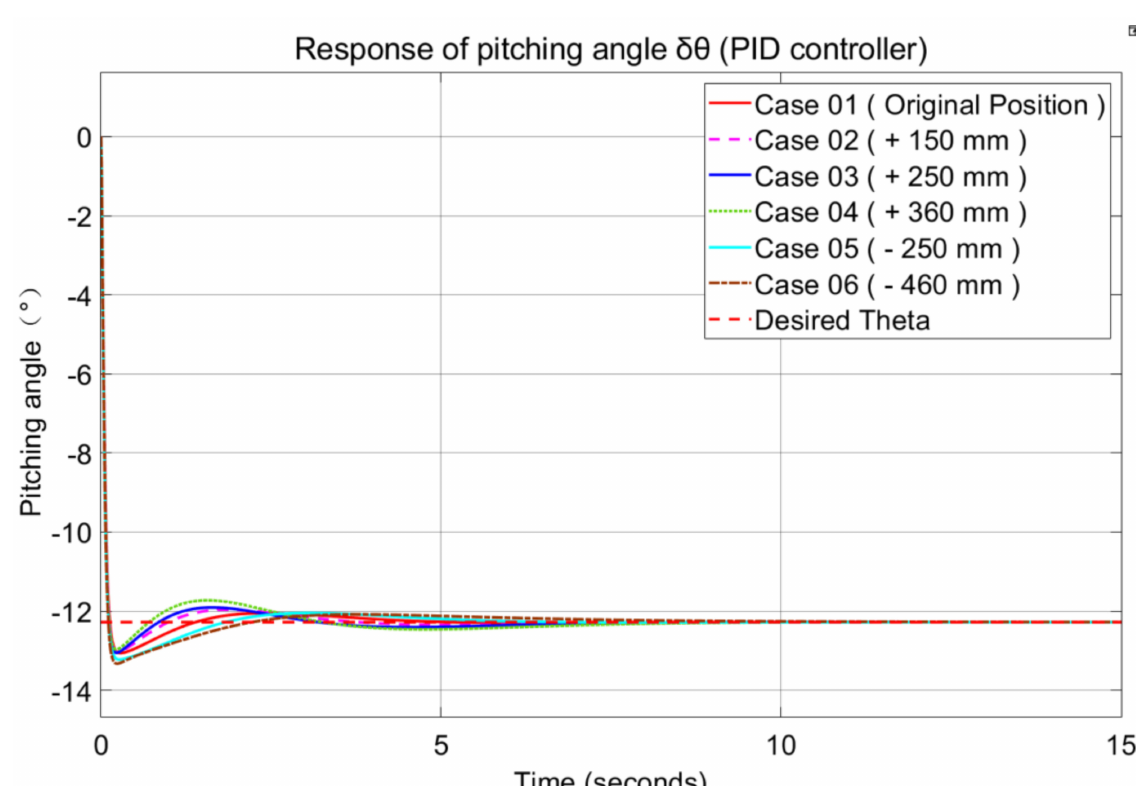
Figure 19. Response of the longitudinal velocity ( δ v 1 ) (open loop).